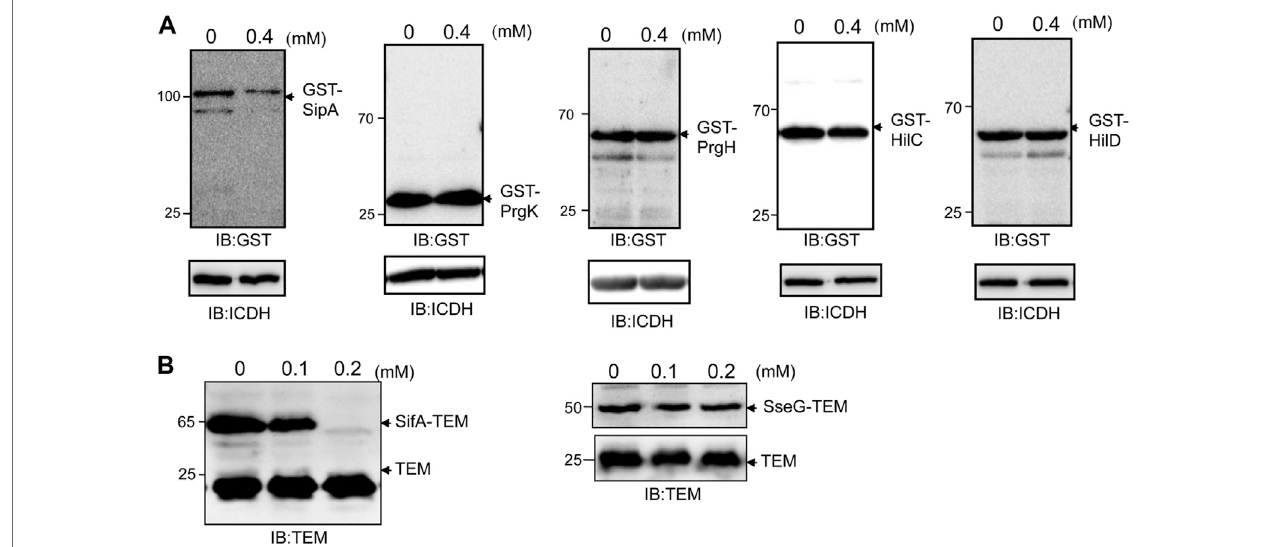
FIGURE 2| Thymol does not affect thestability of all proteins associated withSPI-1. (A) GST fusion of the indicted proteins was expressed in S . Typhimurium with or without thymol for 4 h, and the protein levels were evaluated by immunoblotting with a GST-speci fi c antibody. ICDH was probed as a loading control. Note that only the protein level of GST-SipA decreased in cultures that received thymol. (B) The effects of thymol on the stability of SifA and SseG, two SPI-2 effectors. β -lactamase fusedtoSPI-2effectorSifA(leftpanel),orSseG(rightpanel)wasexpressedfromaplasmidinwild-type S .Typhimuriuminthepresenceofindicatedconcentrations of thymol for 4 h, and the protein was detected by immunoblotting with an antibody speci fi c for β -lactamase. β -lactamase expressed from the plasmid backbone was used as a loading control. The experiments were repeated at least three times each with independent biological samples.